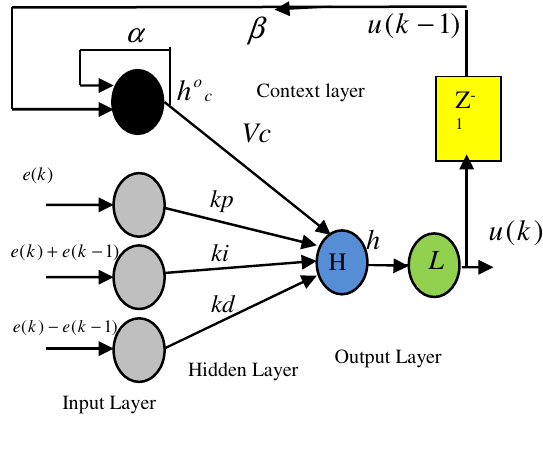
Fig. 3. The new structure of MENN-PID controller.